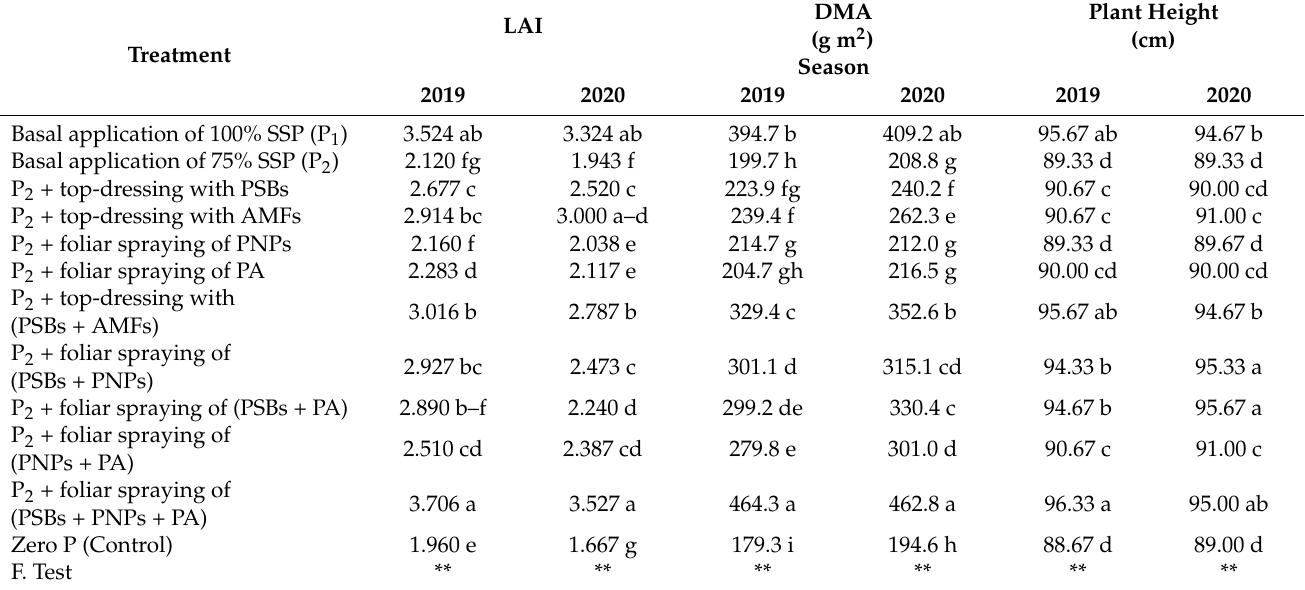
Table 2. Leaf area index (LAI) in the booting stage, dry matter accumulation (DMA) in the booting stage and plant height at harvest of Sakha 106 rice cultivar were affected by arbuscular mycorrhizal fungi, phosphate-solubilizing bacteria and selected chemical phosphorus fertilizers in the 2019 and 2020